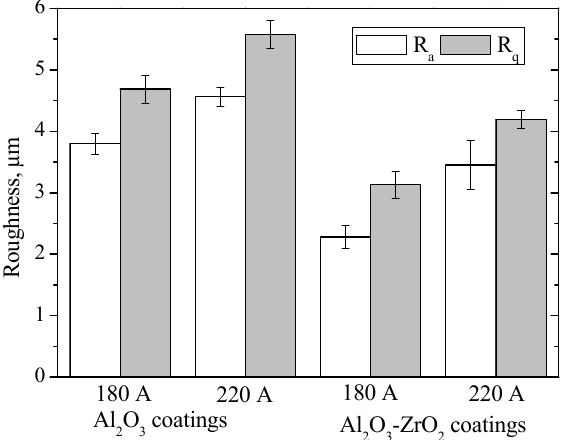
Figure 3. Surface roughness of the Al 2 O 3 and Al 2 O 3 -ZrO 2 coatings. The XRD patterns of the as-sprayed Al 2 O 3 and Al 2 O 3 -ZrO 2 coatings are given in the Figure 4. The Al 2 O 3 coatings consisted of hexagonal β -Al 2 O 3 , rhombohedral α -Al 2 O 3 and cubic γ -Al 2 O 3 phases. It was obtained that the beta-Al 2 O 3 is the dominant phase. The peaks obtained at ~7.8 ◦ , ~15.7 ◦ and ~33.2 ◦ are assigned to sodium aluminum oxide (card No. 32–1033) with the β -Al 2 O 3 (002), (004) and (107) orientations, respectively [12]. The diffraction peaks found at ~25.7 ◦ , ~35.2 ◦ , ~37.8 ◦ , ~43.4 ◦ , ~52.6 ◦ and ~57.6 ◦ are related to α - Al 2 O 3 phase of (012), (104), (110), (113), (024) and (116) orientations, respectively